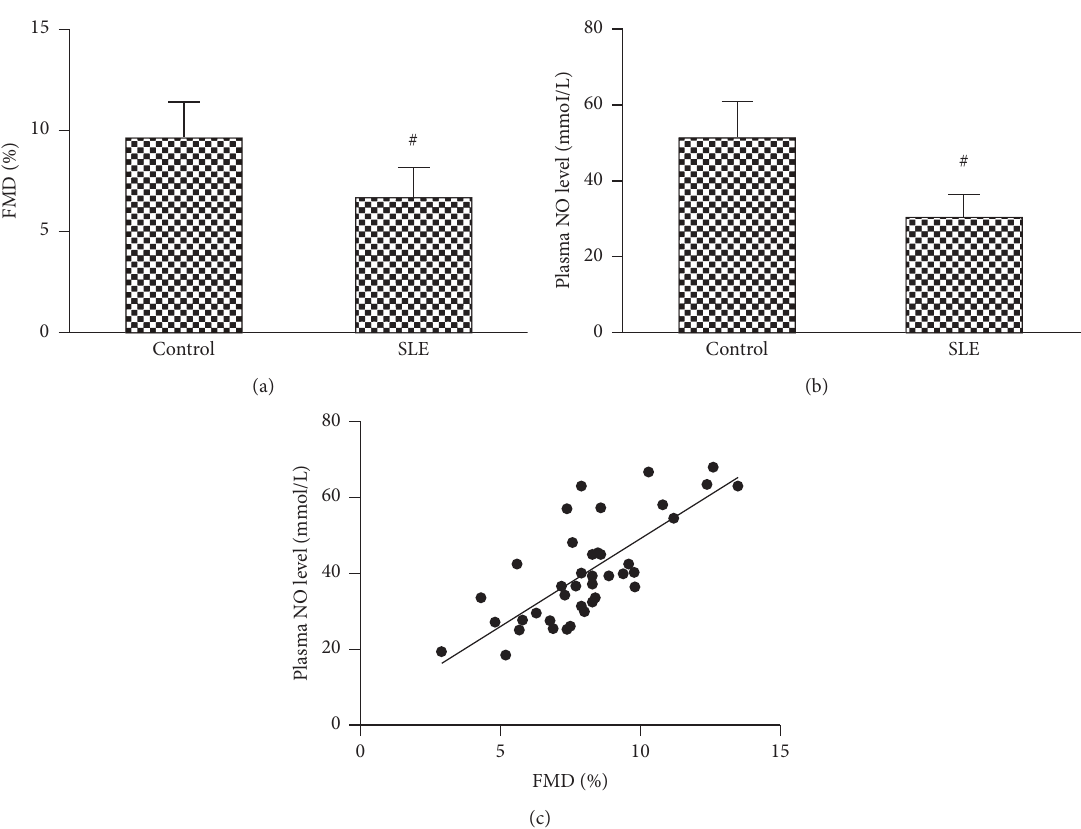
Figure 1: The FMD and plasma NO level in the two groups. The brachial artery FMD (a) and plasma NO level (b) in SLE patients were lower than that in the control subjects. FMD was positively correlated to plasma NO level (c). # P < 0.05 vs. control